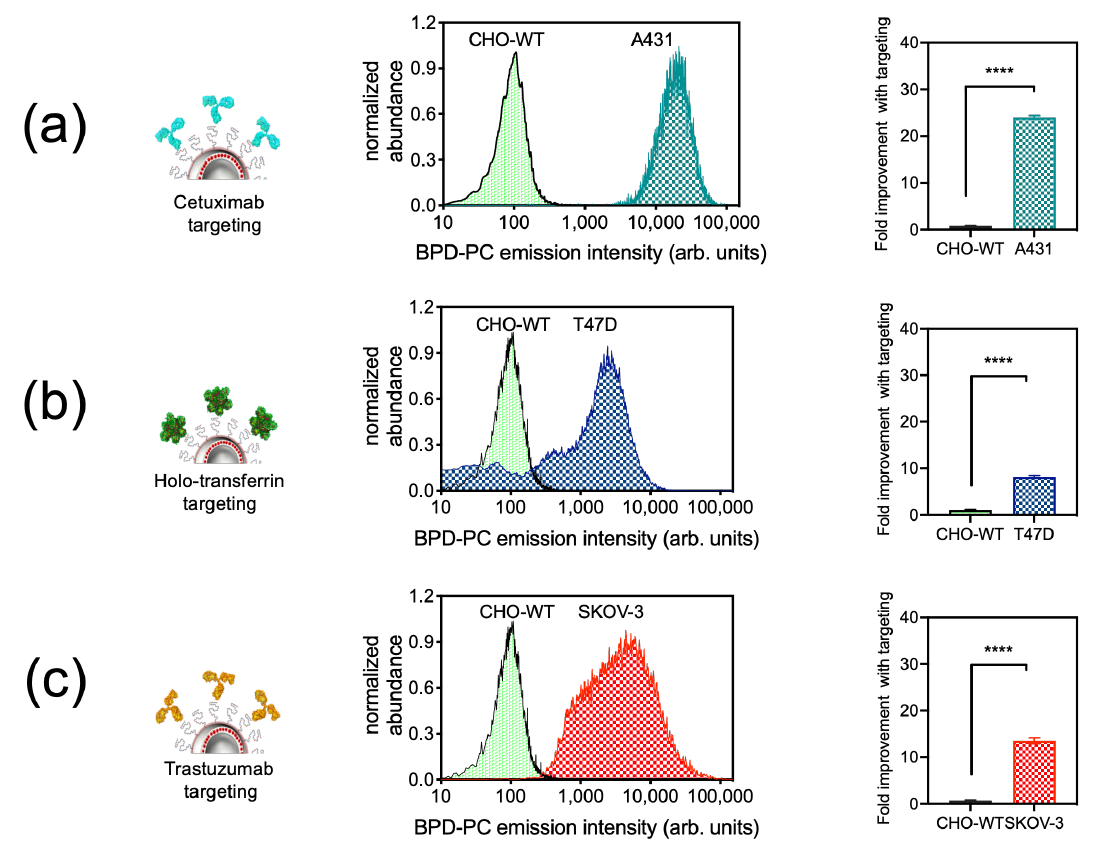
Figure 2. Cellular binding specificity of photoimmuno-nanoconjugates (PINs) to tumor cells over-expressing EGFR, TfR, and HER-2 receptors. Flow cytometry histograms and bar graphs representing the specificity of PINs conjugated to the tumor-specific ligands cetuximab (to target EGFR), holo-transferrin (to target TfR), or trastuzumab (to target HER-2). Binding specificity of ( a ) Cet-PINs to A431 cells (high EGFR), ( b ) HT-PINs to T47D cells (high TfR), and ( c ) TZ-PINs to SKOV-3 cells (high HER-2) is presented with respect to the untargeted-PSNs for each cancer cell line and the control CHO-WT cell line (null for EGFR, TfR, HER-2). (mean ± S.E.M.; unpaired t -test, n = 3 for each cell line; **** = p ≤